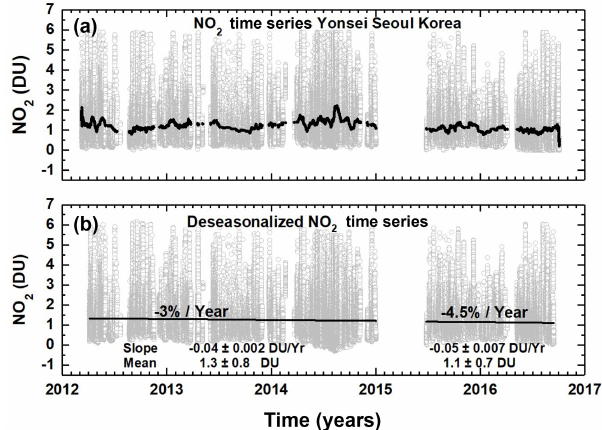
Figure 7. (a) C ( NO 2 ) time series at Yonsei University in Seoul NO 2 (grey) and (b) deseasonalized time series. Combined slope = − 0 . 05 ± 0 . 001DUyr − 1 and mean = 1 . 2 ± 0 . 8DU or the decrease is − 4 ± 0 . 08%yr − 1 . Seoul has no clear seasonal